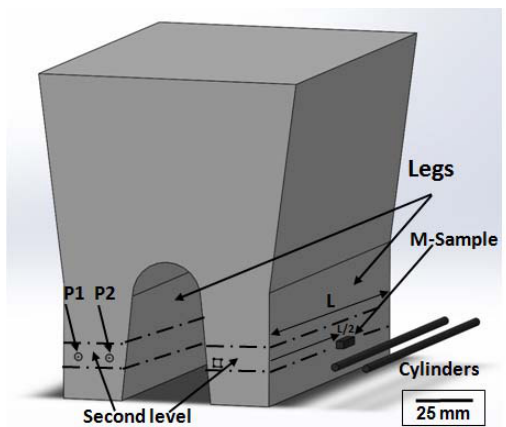
Figure 1. Drawing of a poured keel block. Dilatometry cylindrical samples have been obtained from second level of the keel block legs (P1 and P2 positions). The location of the M-Sample used to characterize the microsegregation and solidification structure has been pinpointed by an